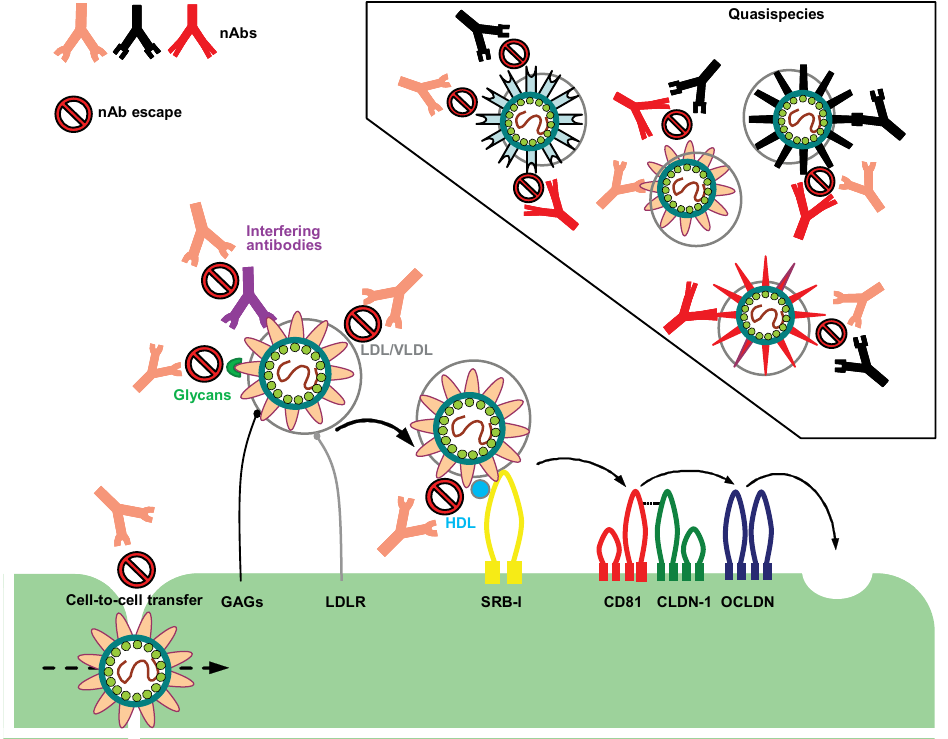
Figure 1. Hepatitis C virus (HCV) entry and escape from nAbs. Several cell surface molecules mediate HCV binding to host cells. GAGs and LDLR may facilitate initial attachment by interacting with HCV glycoproteins and virion-associated lipoproteins, respectively. After the initial binding step, the virion interacts with the entry receptor SR-BI, followed closely by CD81. The tight junction proteins claudin-1 (CLDN-1) and occludin (OCLDN) also contribute to binding, uptake and internalization of HCV by receptor-mediated endocytosis. The failure of nAbs in controlling HCV infection could be caused by several different factors. HCV can rapidly evolve into many quasispecies within an infected individual, therefore outpacing the nAb response; virion-associated lipoproteins and glycans may protect the envelope glycoproteins from nAbs; the presence of interfering Abs could diminish the function of nAbs by preventing them from binding to viral glycoproteins; virus entry may be enhanced by HDL therefore reducing the time window during which the Abs can bind to and neutralize the virus; HCV can infect surrounding cells through direct cell-to-cell contact therefore avoiding being exposed to nAbs. Adapted from Zeisel et al. [16] and Angus and Patel [17]. GAG: Glycosaminoglycan; LDL: Low density lipoprotein; VLDL: Very low-density lipoprotein; HDL: High-density lipoprotein; LDLR: Low-density lipoprotein receptor; SR-BI: Scavenger receptor class B; nAb: neutralizing